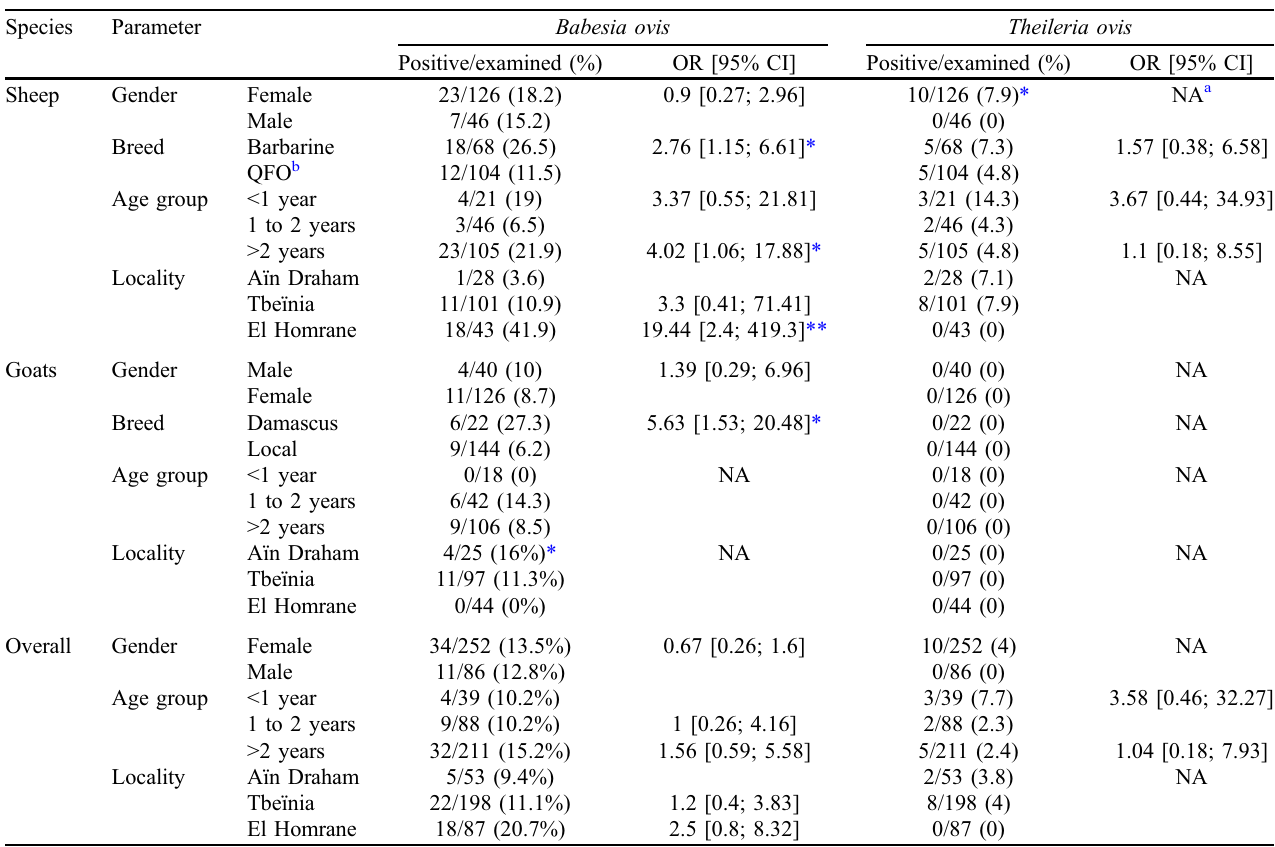
Table 4. Association between the presence of sheep and goat piroplasms and different parameters based on